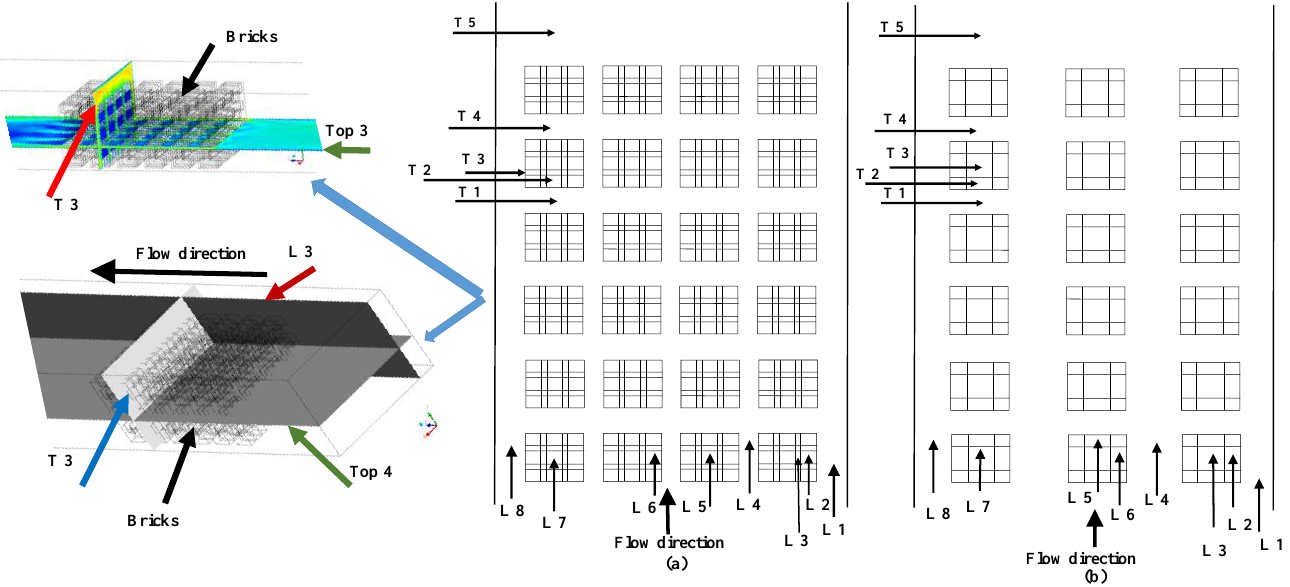
Figure 5. Longitudinal and transversal planes in two settings: ( a ) setting 1, ( b ) setting 3.